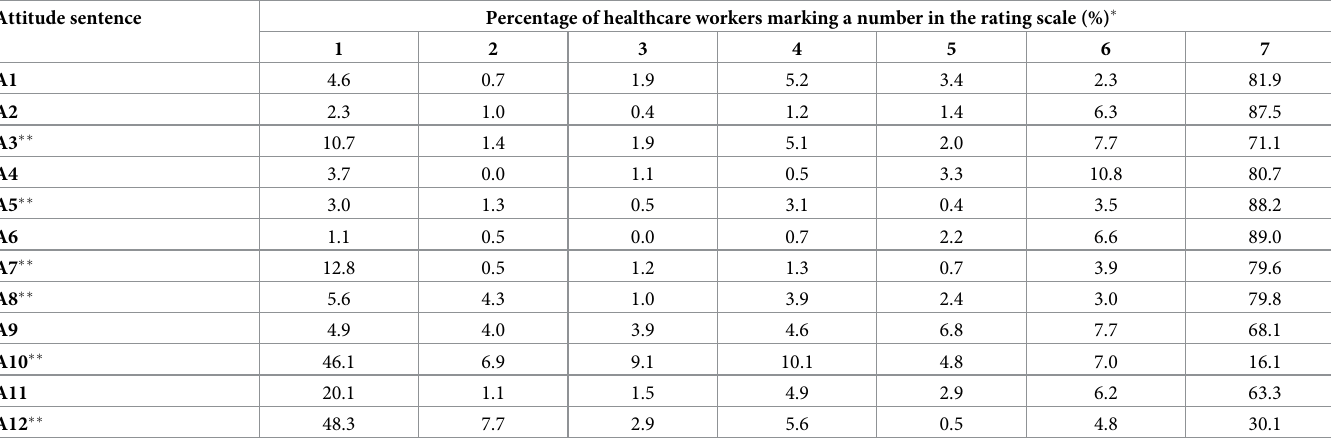
Table 7. Healthcare workers’ responses to twelve attitude questions. Attitude